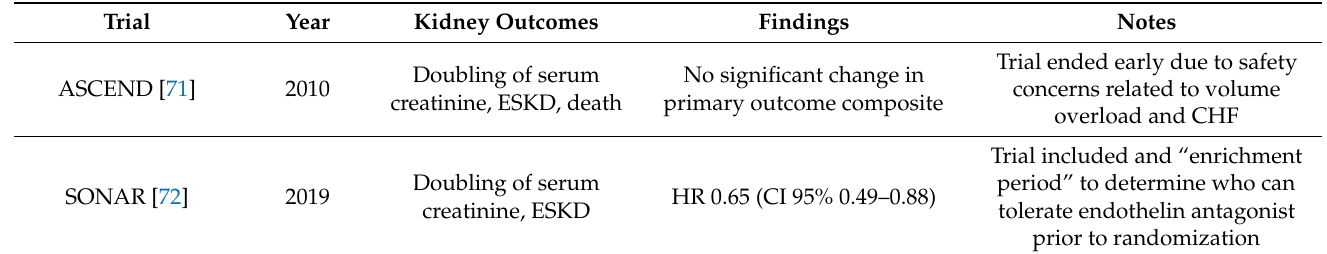
Table 5. Summaries of landmark trials with endothelin receptor